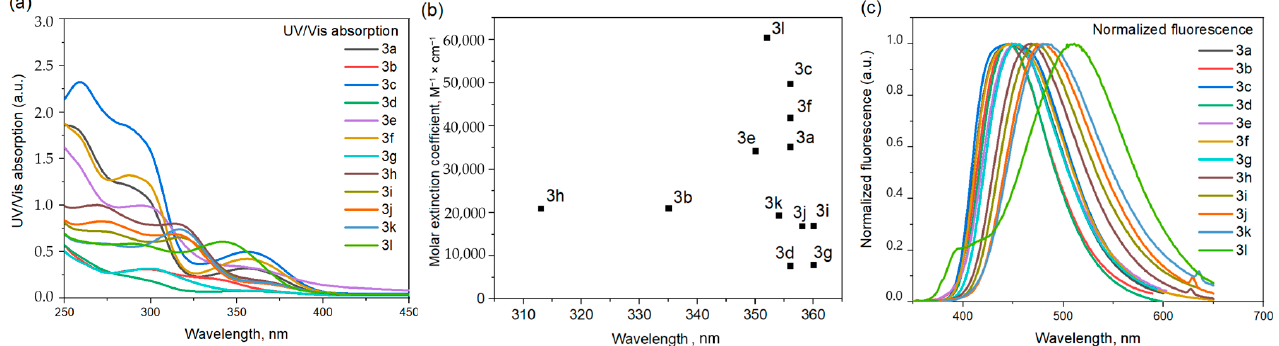
Figure 3. UV/Vis spectra ( a ), molar extinction coefficient, and ( b ) normalized fluorescence ( c ) spectra for 3a–l in THF solutions at room temperature . The concentration of all fluorophores was 10 − 5 M.